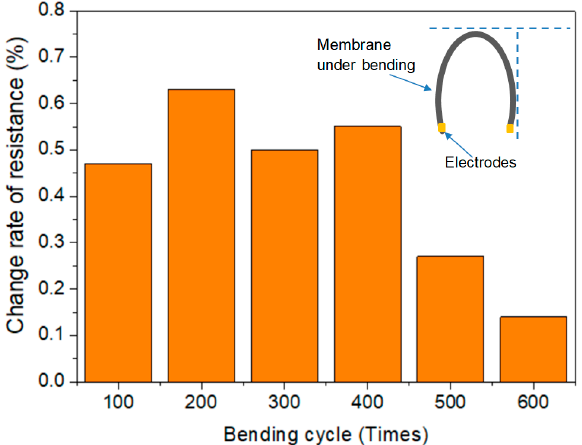
Figure 10. Stability of resistance between two electrodes of the 55 wt.% graphene membrane with grammage of 16 g·m − 2 after different bending cycles.